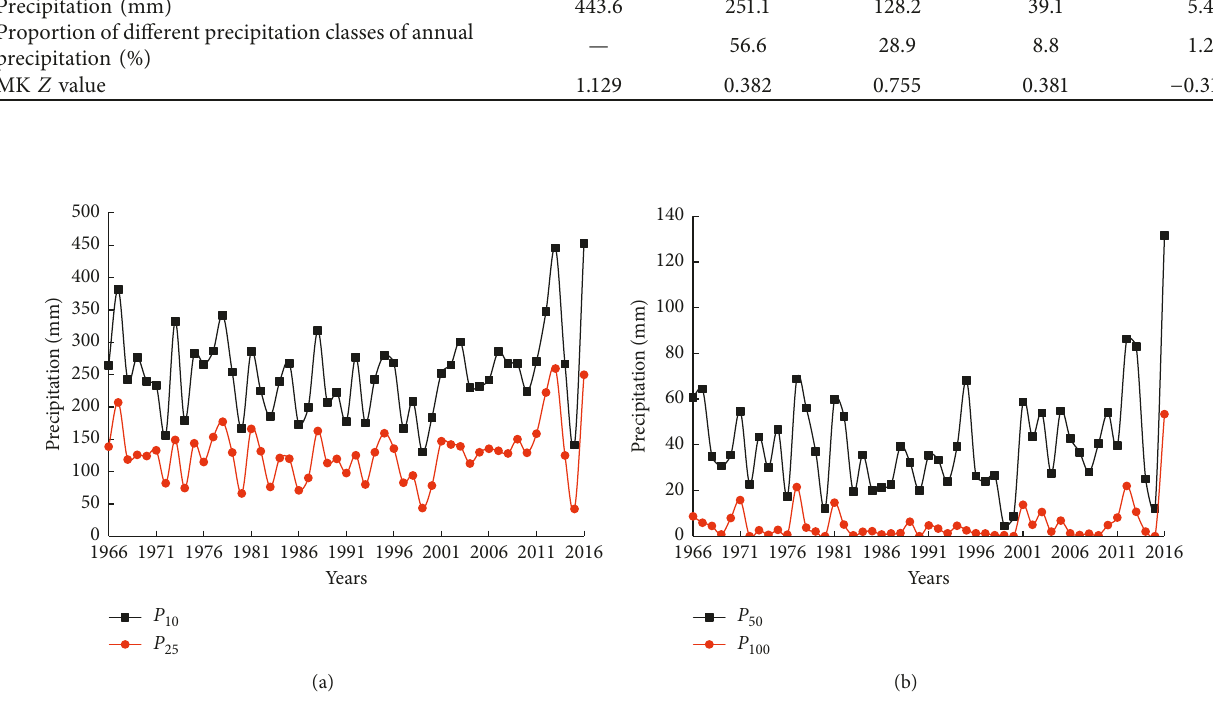
Figure 4: Time series of different classes of precipitation in the HLR from 1966 to